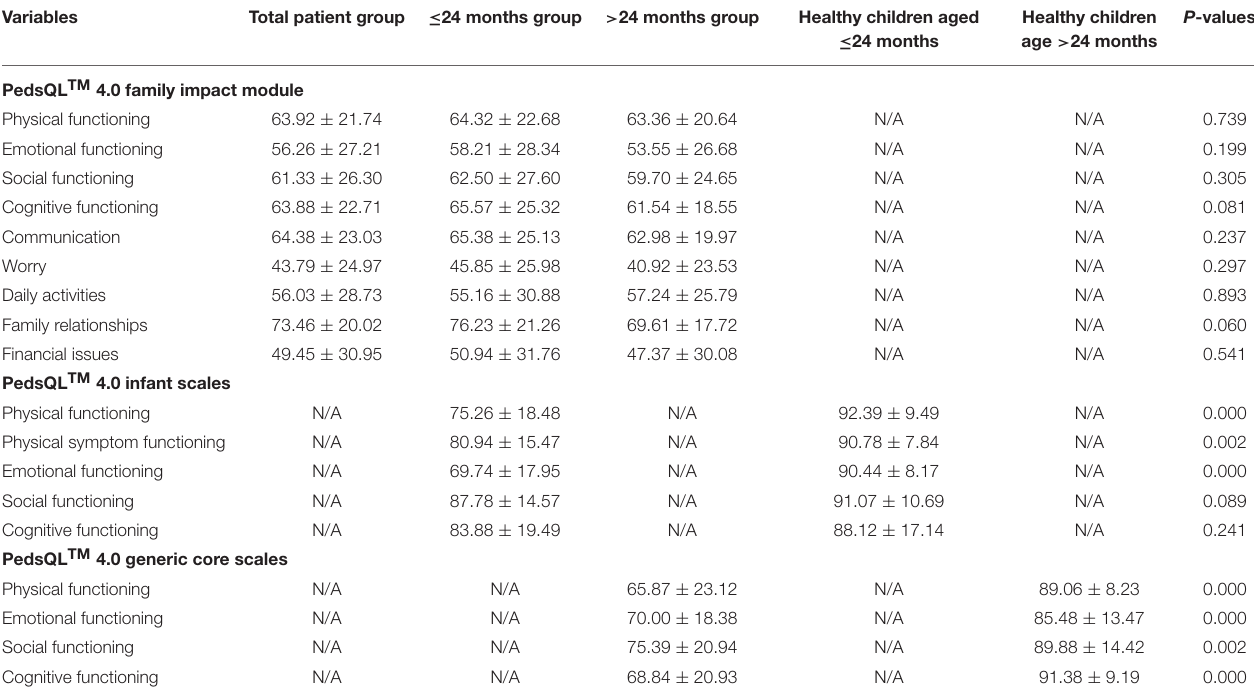
TABLE 3 | Scores of each instrument in the patient group and healthy group.